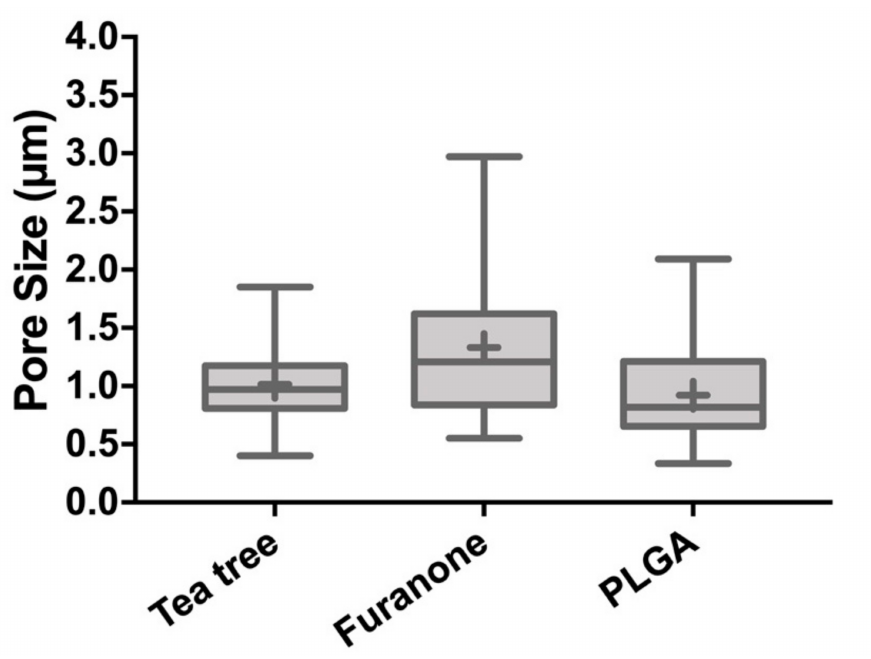
Figure 4. Average Pore size of PLGA loaded with tea tree essential oil, PLGA loaded with furanone, and pure PLGA fiber membranes (no statistically significant difference).